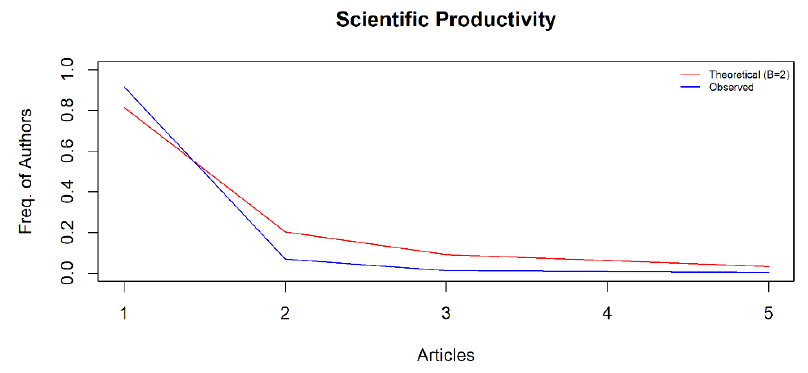
Figure 4. L otka’s law of scientific